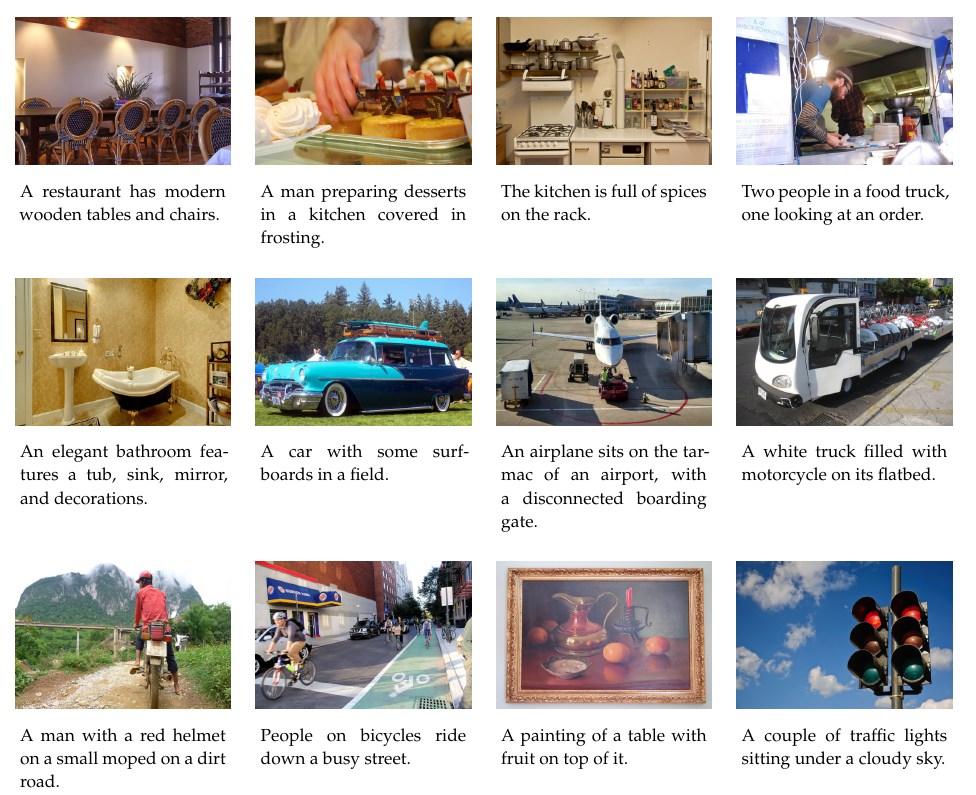
Figure 4. The images which are randomly chosen from the Microsoft (MS) COCO dataset. The text under each image shows the first sentence from the five ground truth caption sentences associated with the